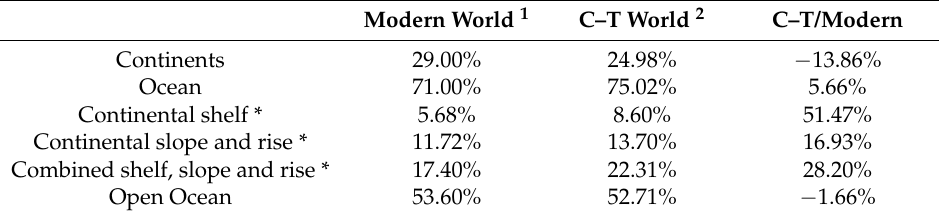
Table 2. Comparison of area between modern and C–T